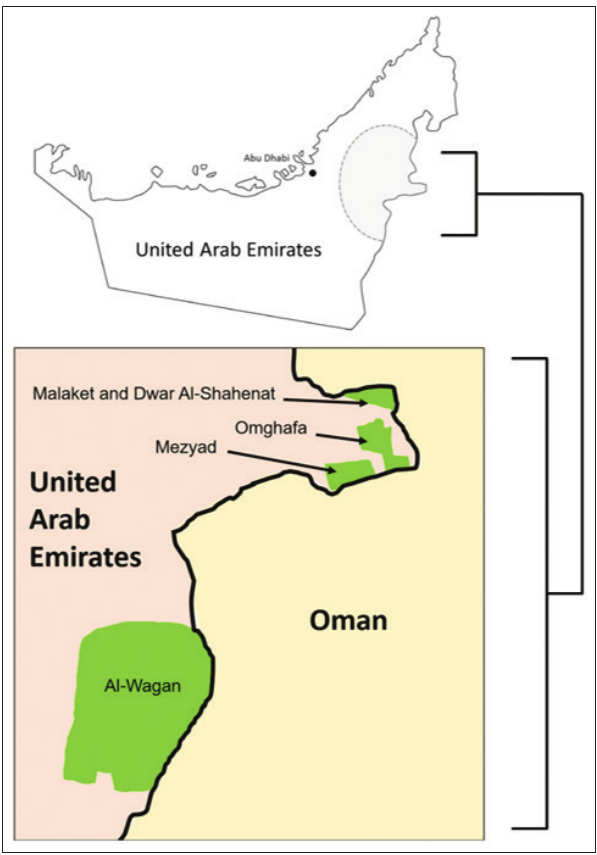
Figure-1: Upper map: The shaded area represents the locations of the camel farms visited in the current study. Lower map: Green areas are the possible points for cross- border tick movement between the United Arab Emirates and Oman [Source: Figure prepared by MAA].